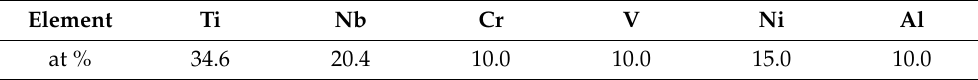
Table 1. The chemical composition of Ti ‐ Nb ‐ Cr ‐ V ‐ Ni ‐ Al.